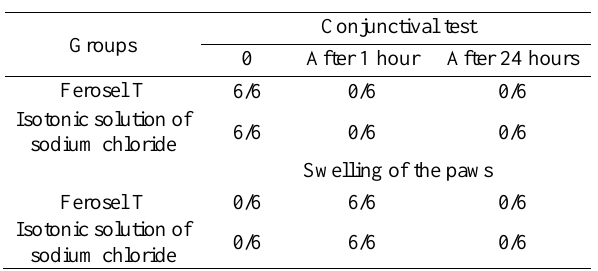
Frequency of detection of hypersensitivity in guinea pigs after intradermal administration of ferrocellus T by conjunc- tival test and swelling (n = 6)